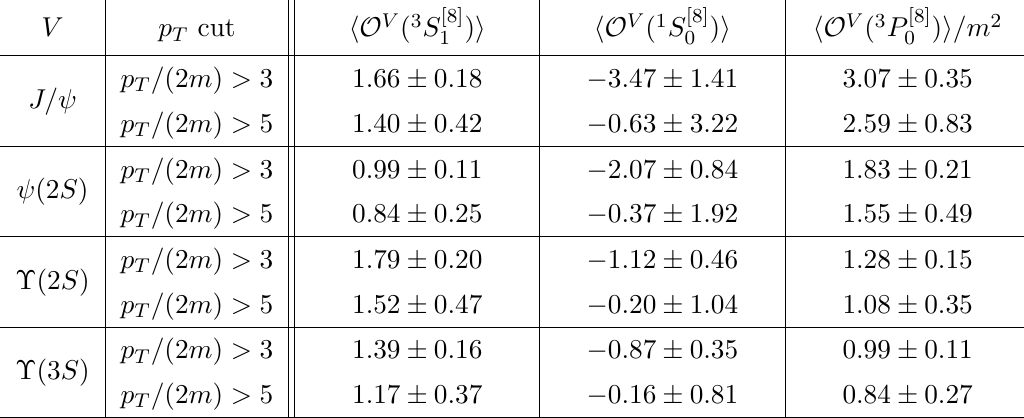
Table 2 . Results for the color-octet LDMEs for V = J/ψ , ψ (2 S ) , Υ(2 S ) , and Υ(3 S ) states computed from eqs. (3.48) and the fit results for the gluonic correlators in table 1, in units of 10 − 2 GeV 3 for p T cuts p T / (2 m ) > 3 and p T / (2 m ) > 5 . The 3 S [8] LDME is renormalized in the MS scheme at 1 scale Λ = m